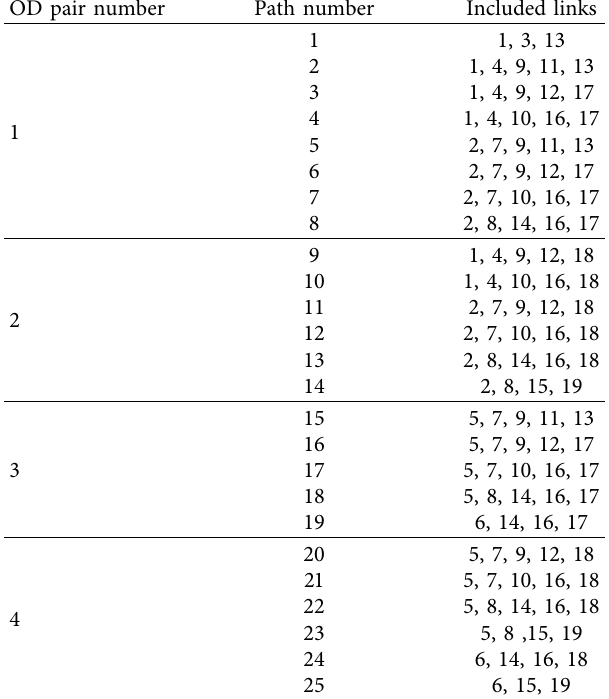
Table 4: The index of road network